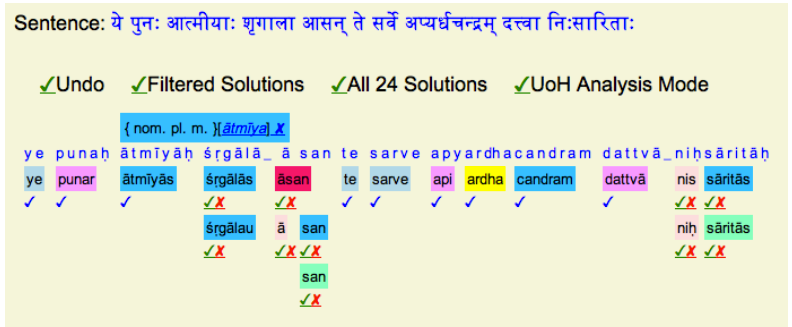
Figure 13: Revised interface for the